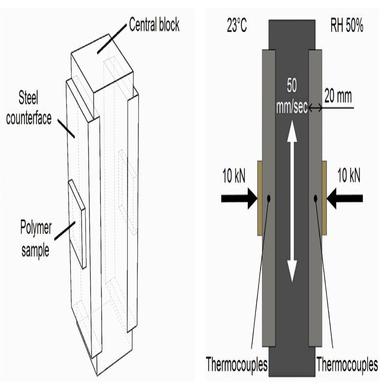
Schematic representation of linear reciprocating sliding flat-on-flat tribotester set up.